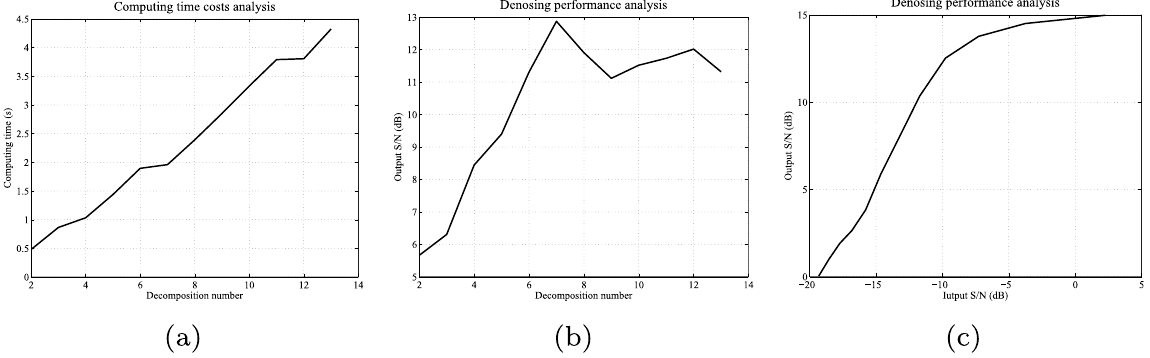
Figure 3. Efficiency and effectiveness analysis of the orthogonalized morphological reconstruction.